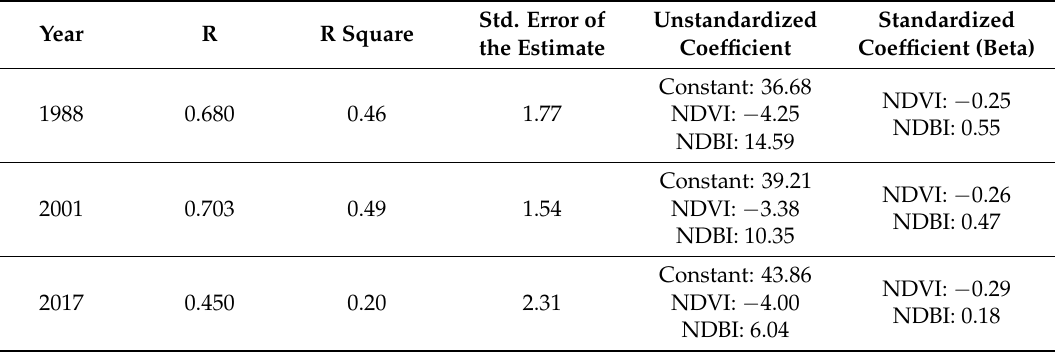
Figure 6. 2D and 3D scatterplots of the NDBI-LST and NDVI-LST relationships. Table 6. Details of the multiple linear regression model.